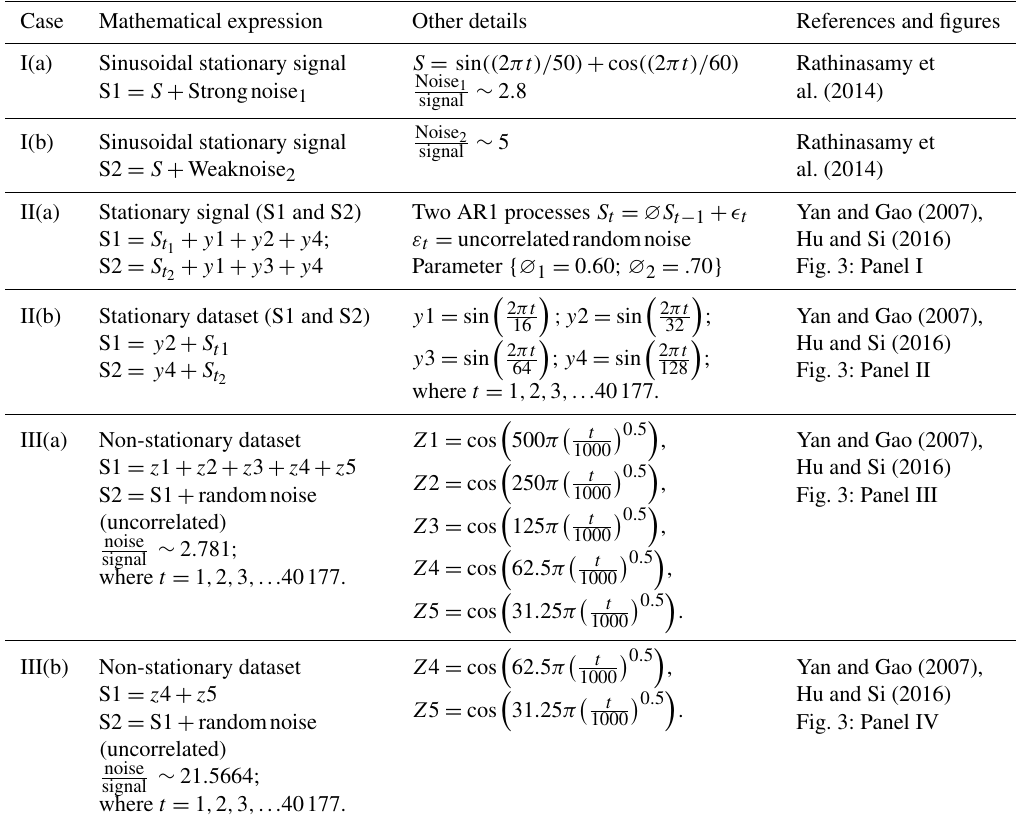
Table 1. Details of synthetic test